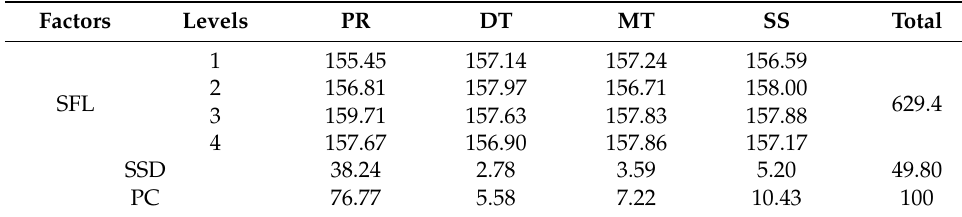
Table 3. Results of Pareto ANOVA for HV (S/N ratio).